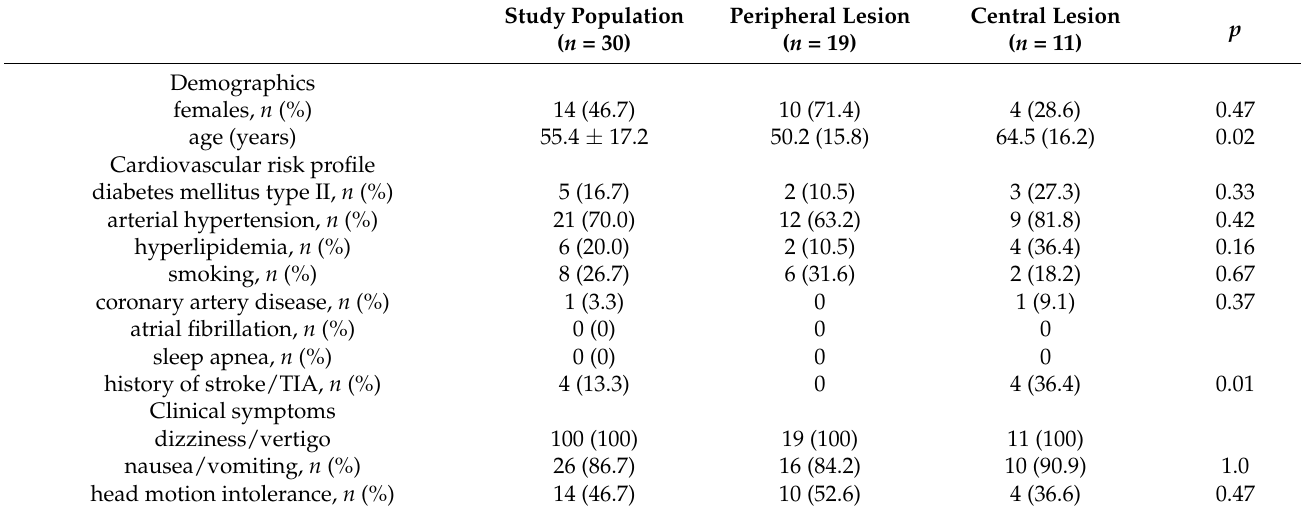
Figure 1. STARD Flow diagram. ( A ) C-HINTS plus; ( B ) V-HIT assisted HINTS plus; ( C ) Cal-NTS plus. Table 1. Demographics and baseline